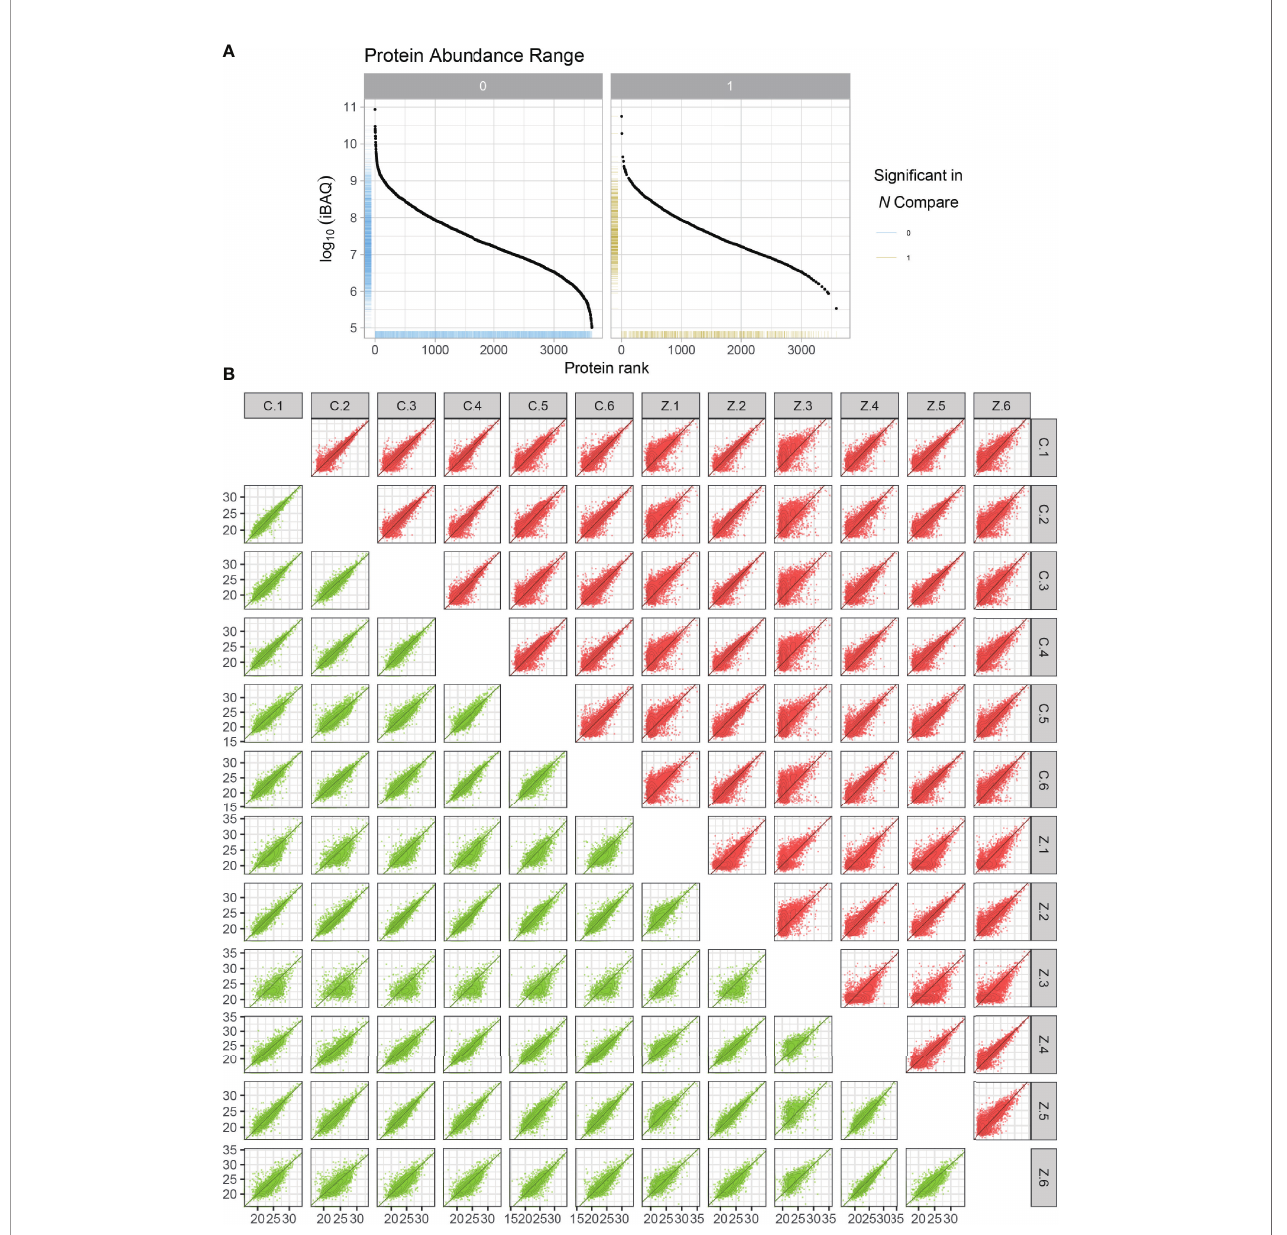
FIGURE 1 | Protein abundance plots and quantitative correlation analysis between samples. The plot of protein abundance is indicated in (A) The plot of quantitative correlation analysis between samples is indicated in (B) The plot of protein abundance is indicated in (B) The plot of protein abundance is indicated in (B)